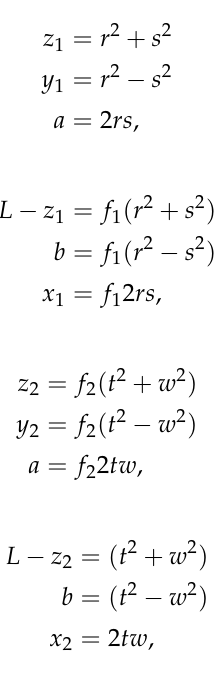
Figure 4. SPL, with the solutions in quadrant